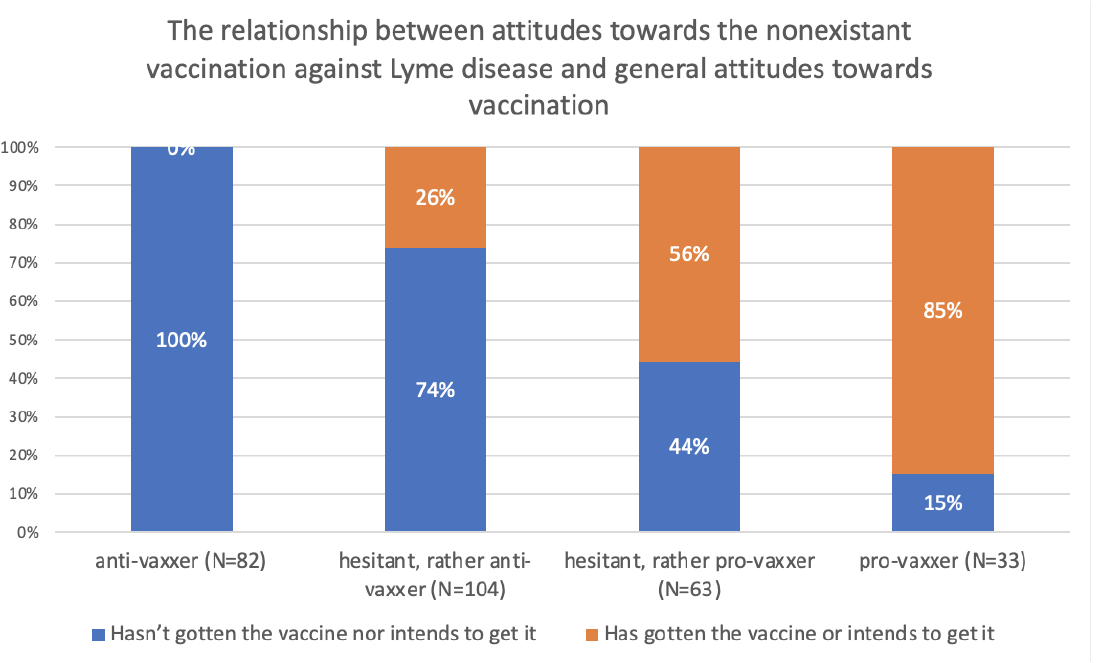
Figure 1. Validation of the Piresian vaccine with the traditional objective measurement of vaccine 221 hesitancy. 222